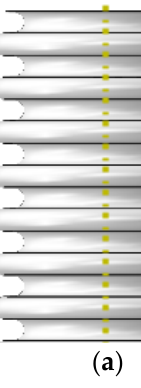
Figure 2. Geometric models of the two types of U-shaped bellows; ( a ) toroid bellows and ( b ) spiral bellows.